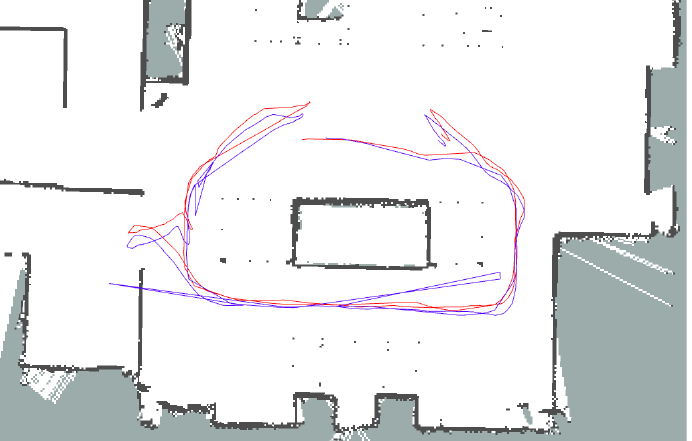
Figure 15. Path of robot, where the red lines indicate the path estimated by the robot and the blue lines indicate the paths measured by the MoCap system.